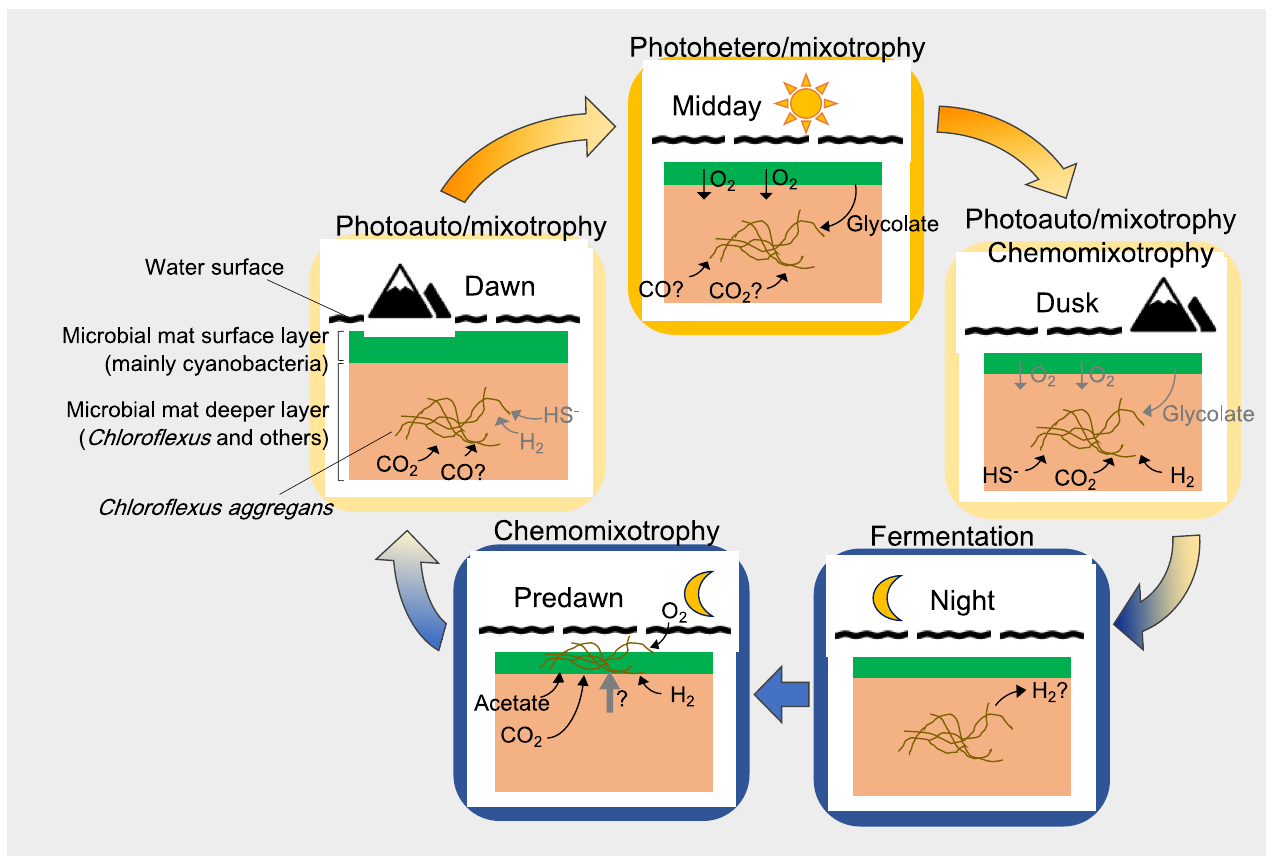
Figure 9. Proposed diel growth modes of C. aggregans (indicated by brown filaments) in cyanobacterial mats based on in situ metatranscriptomic and microsensor analyses in the cyanobacterial mats of Nakabusa Hot Springs. The green area represents the green upper layer containing oxygenic phototrophs (i.e., cyanobacteria), while the orange area corresponds to the orange colored undermat. The black curvy line indicated the overflowing water surface. Supplementary Materials: The following are available online at https://www.mdpi.com/2076 Figure S2: Relative transcription levels of housekeeping genes; Figure S3: Relative transcription levels of genes related to oxidative stresses; Figure S4: Relative transcription levels of amino acid and oligopeptide transporter genes; Figure S5: Relative transcription levels of glycoside and sugar transporter genes; Table S1: Transcriptomic profiles and differentially transcribed genes; Table S2: Differential transcription analyses of genes involved in energy metabolisms of C. aggregans ; Table S3: Summary of differentially transcribed genes; Table S4: Transcription patterns of bch genes; Table S5: Transcription patterns of genes involved in energy metabolisms of C.